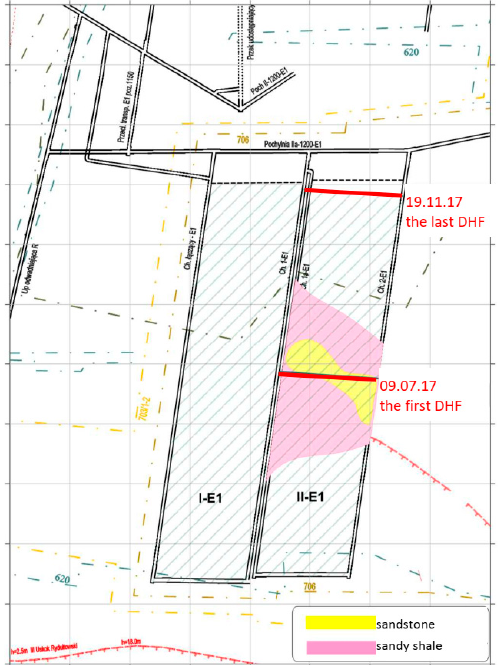
Figure 1. Map of coal seam 713/1-2 with signified region of hydraulic fracturing in longwall II-E1. 134 Table 1. Shocks registered during the exploitation of seam 713/1-2 at longwall I-E1. 135